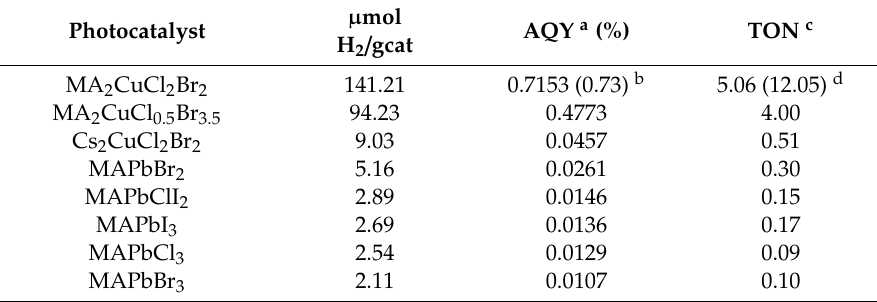
Table 1. H 2 production data at 24 h of reaction for different types of perovskites *. µ Photocatalyst